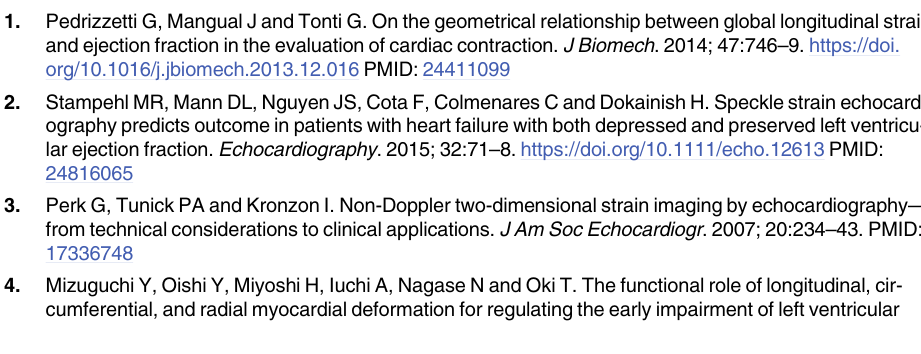
Figure G. Percentiles of early diastolic strain rate in men. Figure H. Percentiles of early dia- stolic strain rate in women. Figure I. Percentiles of late diastolic strain rate in men. Figure J. Percentiles of late diastolic strain rate in women. Figure K. Number of male individuals with 0–5 cardiovascular risk factors by age. Figure L. Number of female individuals with 0–5 cardio- vascular risk factors by